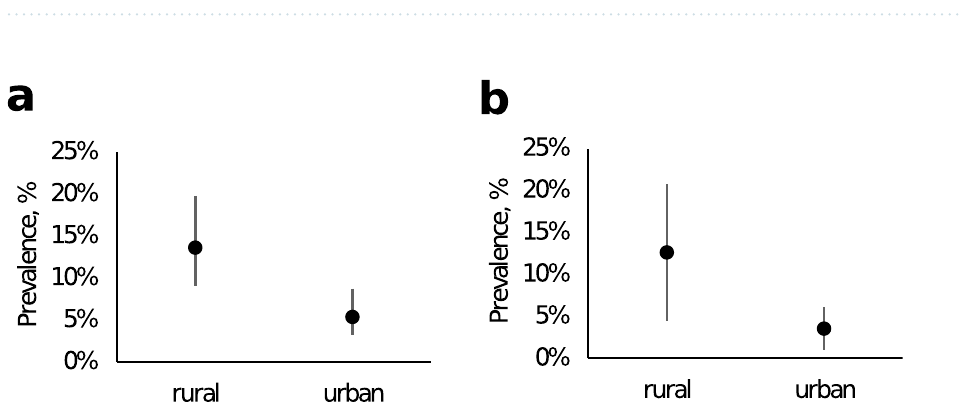
Figure 3. Observed and estimated T. gondii prevalences in rural and urban areas. ( A ) Observed prevalences among the small mammals captured in rural and urban areas. The observed prevalence and 95% CIs are shown. ( B ) Estimated prevalences from the fitted model. Values for vegetation and species were set to zero (forest and non-alien species) in the model. Estimated prevalences (black circles) and 95% CIs are